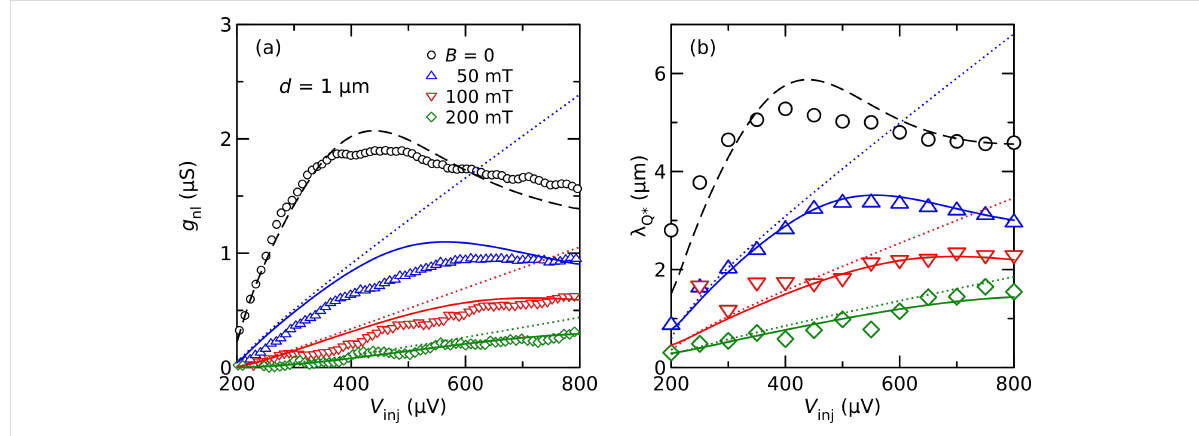
Figure 2: (a) Nonlocal conductance of one contact pair of an NISIN sample with d = 1 μ m as a function of the injector bias V inj for different magnetic fields B . (b) Charge imbalance relaxation length . Data taken from [12], the lines are various model predictions explained in the text.